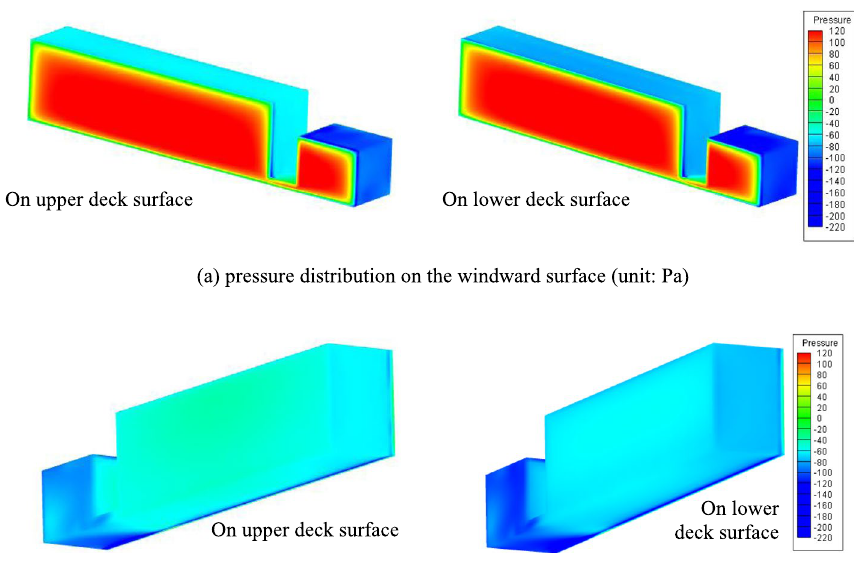
Fig. 20 Counters of the mean velocity for different cross sections (vehicle on lane